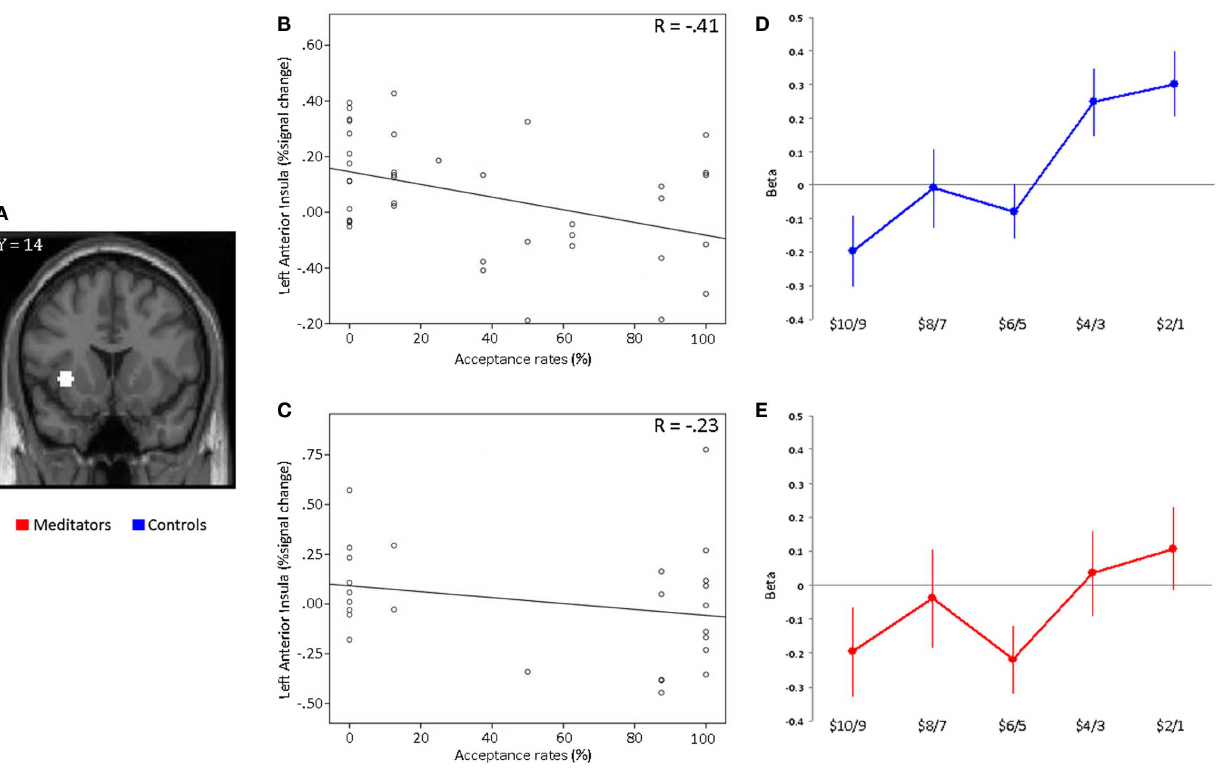
FIguRe 4 | RoI analysis in anterior insula. (A) Plots of beta estimates drawn from 5 mm ROIs in left anterior insula based on coordinates from a previous study (Sanfey et al. , 2003) . Activity within the left anterior insula is plotted against acceptance rates for the most unfair offer sizes ($19:1–$18:2) for each participant separately for (B) controls and (C) meditators. The Pearson correlation coefficient